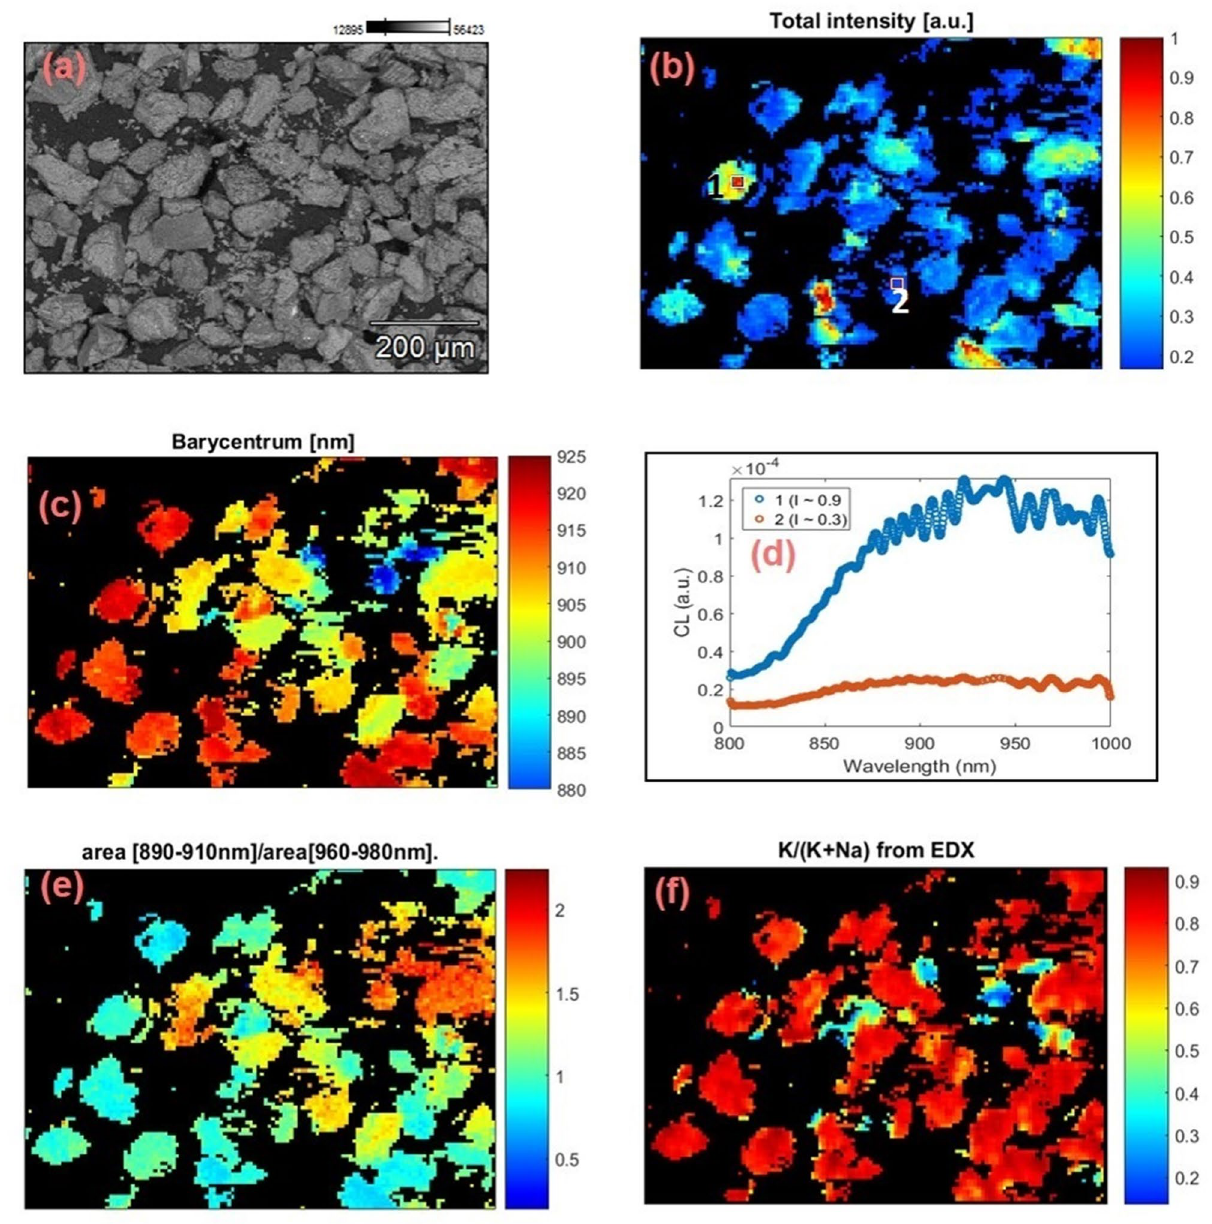
Figure 3. CL and elemental data (CL-EDX) for sample R43. ( a ) BSE image, ( b ) cathodoluminescence intensity map; intensity below a normalized value of 0.135 I max has been filtered out using a mask, ( c ) barycenter map in the range 880–925 nm, ( d ) local CL spectra of two regions at intensities, I ≈0.9 I max and ≈0.3 I max on the intensity map (square labeled regions 1 and 2 in b ), ( e ) relative concentration map of the K-content (K/K + Na), and ( f ) intensity ratio map between the two NIR bands (890–910 nm and 960–980 nm). These images were generated using Matlab (Version: R2016, Url: https ://www.mathw orks.com/produ cts/matla